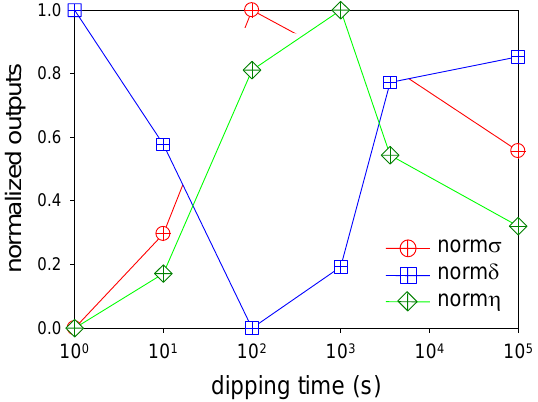
Figure 3. Normalized outputs of AA-PSP. The pressure sensitivity is shown as norm  , the temperature dependency as norm  , and the signal level as norm  ,